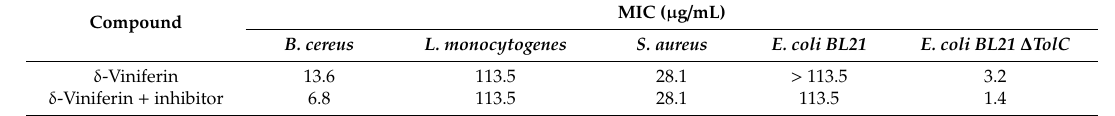
Table 16. MIC values of δ -viniferin from Mora-Pale et al. (2015) [114]. Compound